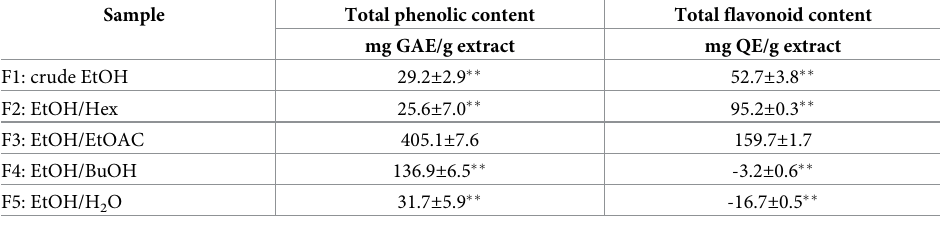
The values are presented as means ± SEM (n = 3). �� p < 0.001, compared with F3: